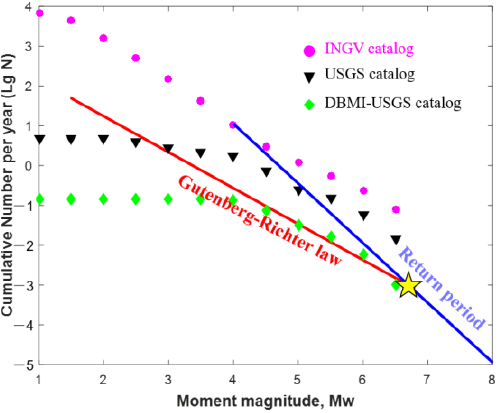
Figure 4. Seismic slip budget closure test on the 2016 central Italy earthquake sequence. The red line represents the G – R law fitted by the DBMI-USGS catalog. The blue line shows the return period of the maximum magnitude event given in Equation (1). The yellow star depicts the intersection of the blue line and red line, giving a maximum magnitude of 6.7 and a return period of 1064 years.